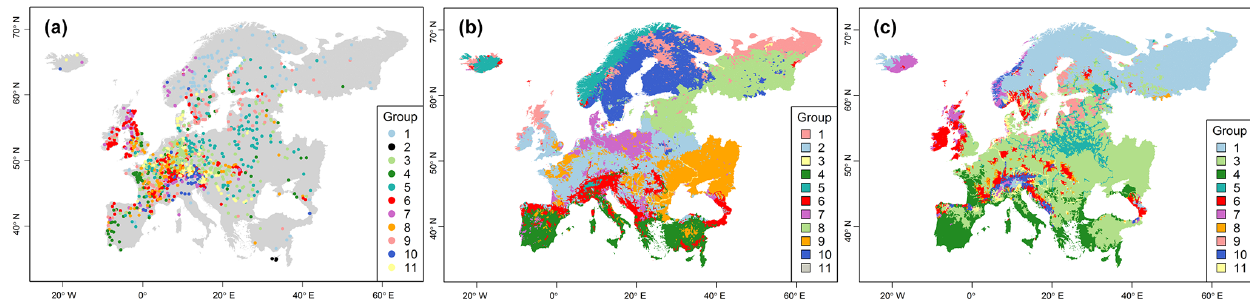
Figure 3. Spatial patterns of catchment classification across Europe based on (a) flow signatures at flow gauges, (b) catchment descriptors, and (c) a CART predictive regression